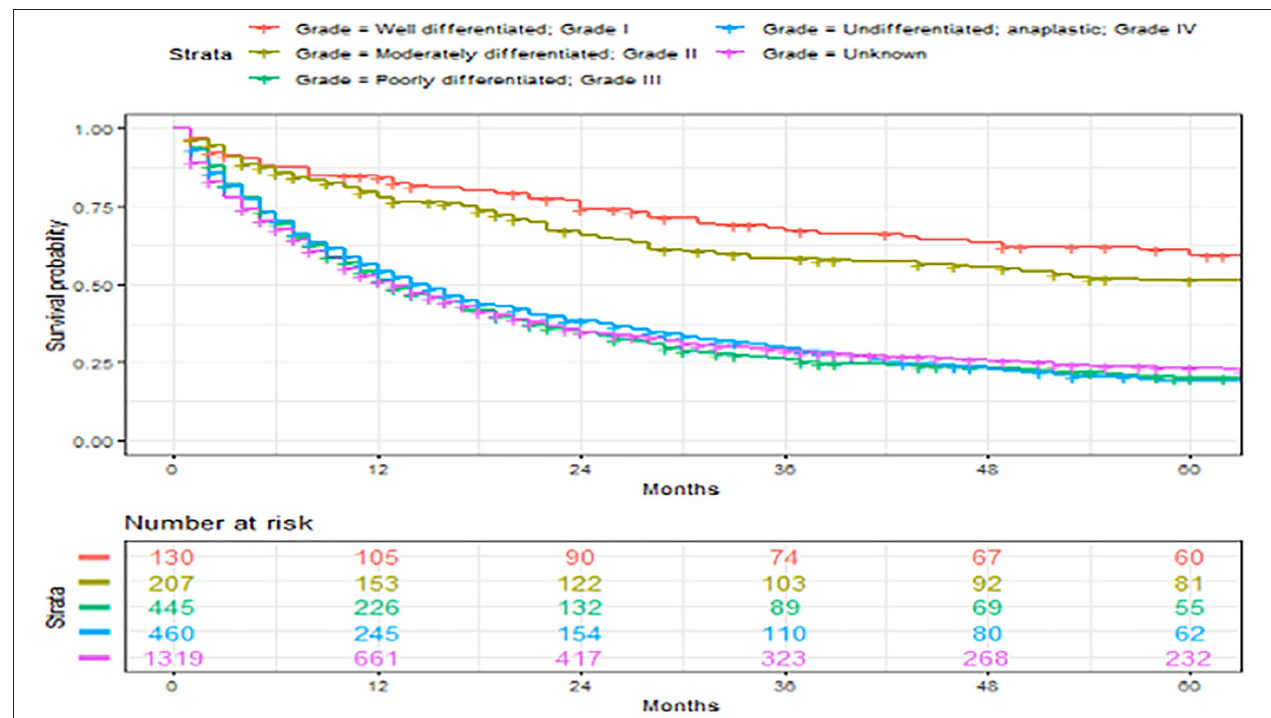
FIGURE 3 | Overall survival of patients with angiosarcoma stratified by primary sites. Survival was calculated using the Kaplan-Meier methods.